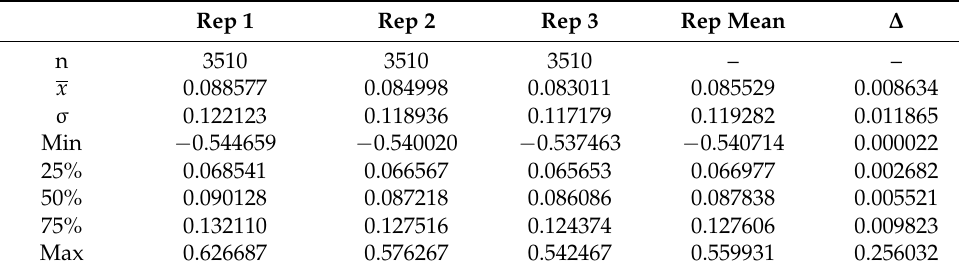
Table 8. Aggregated data for repeated measurements.